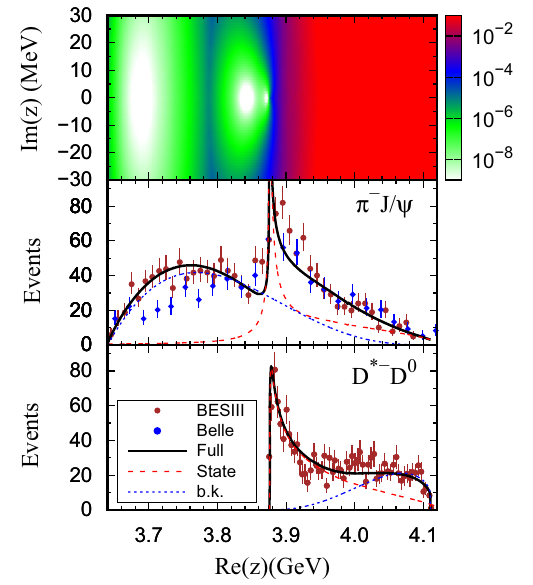
Fig. 3 The log | 1 − V ( z ) G ( z ) | for the π − J /ψ − D − D ∗ 0 − D ∗− D 0 interaction(upper panel). The invariant mass spectra for the π − J /ψ (middle panel) and the D ∗− D 0 with 1 + ( 1 + ) (right panel) are drawn to the same